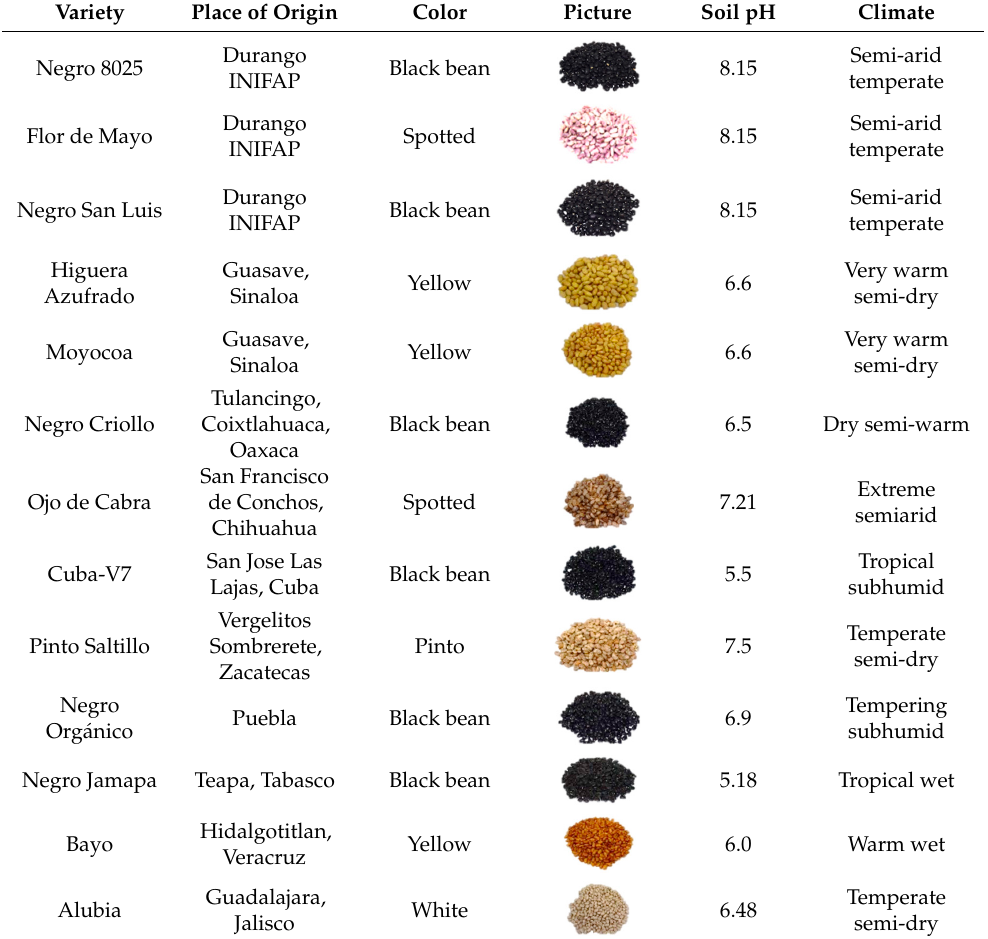
Table 5. Common bean varieties, place of origin, color of seeds, soil pH and climate of the region of origin.